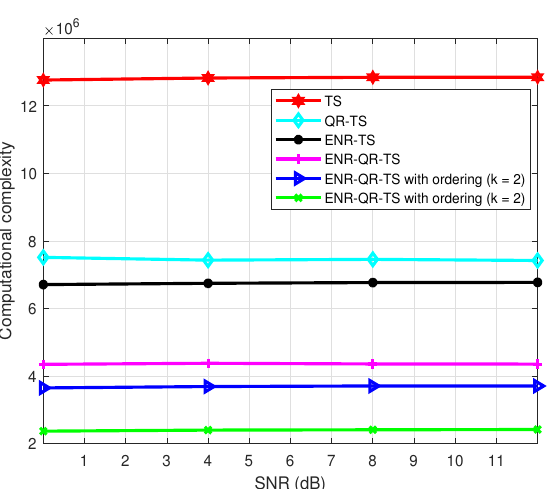
Figure 5. Comparison of the computational complexity of TS algorithms for a 32 × 32 MIMO system with